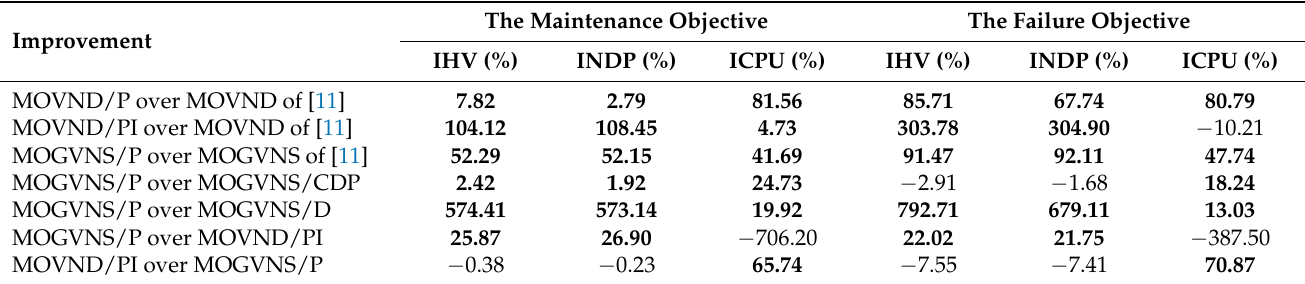
Table 2. Comparisonbetween the proposed algorithms and the literature